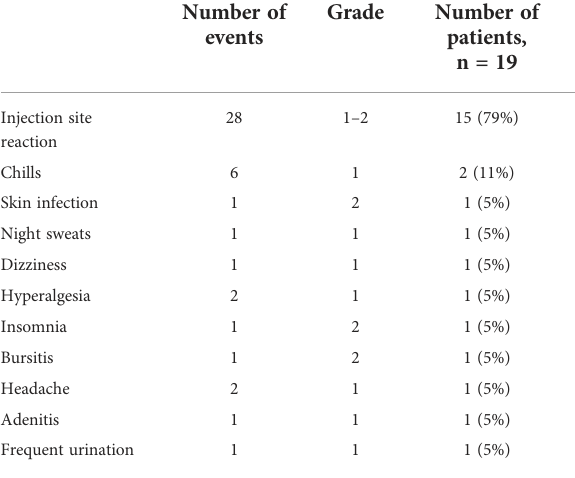
TABLE 2 Adverse events related and possibly related to the vaccine. Number of Grade Number of events